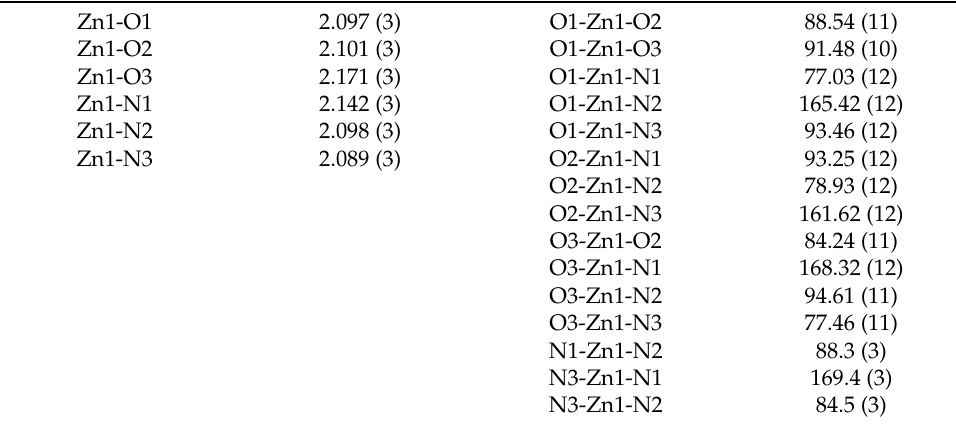
Table 4. Selected bond distances and angles [Å, ◦ ] for 3 .